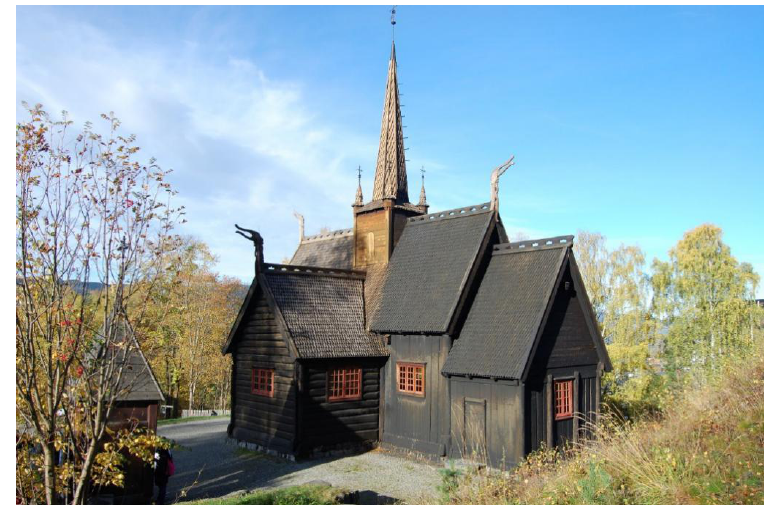
Figure 5. Garmo Stave Church, Lillehammer. Photo: NIKU.